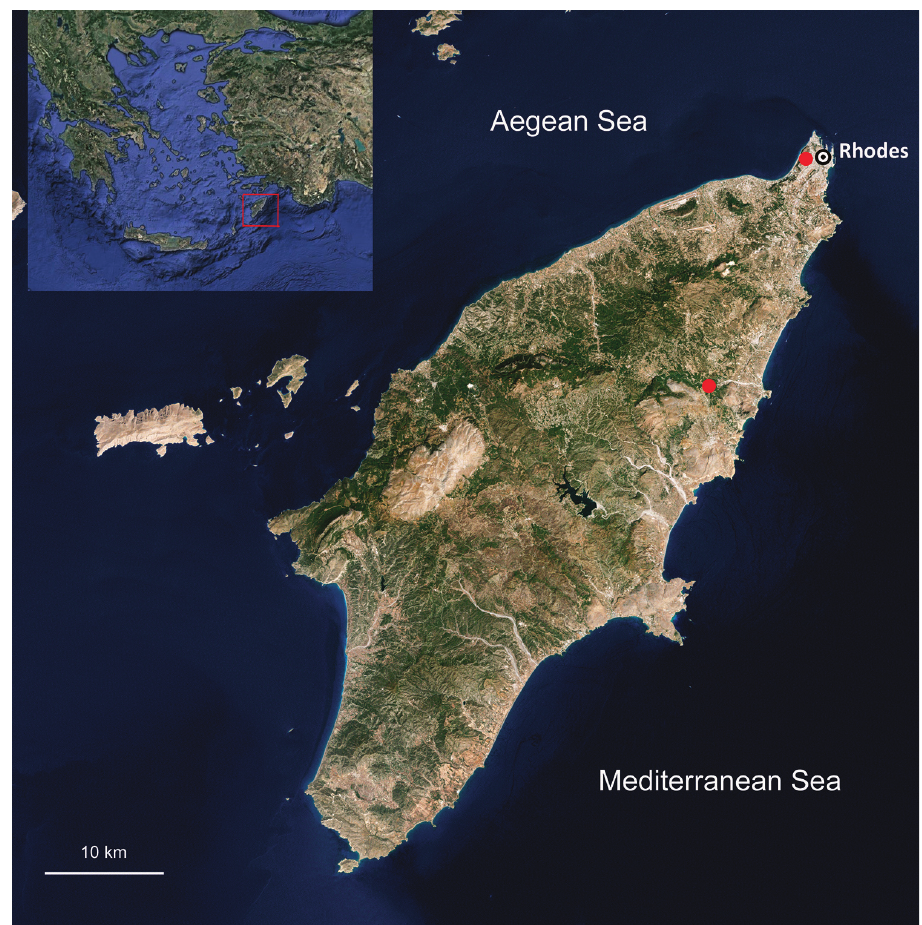
Figure 1. Occurrence of Cryptorchestia ruffoi sp. n. on Rhodes, Greece (MSNVR). In the north, near the town of Rhodes, the locality of 1928 on Monte Smith. The other place represents small streams in the vicinity of Psintos, Epta Piges spring and